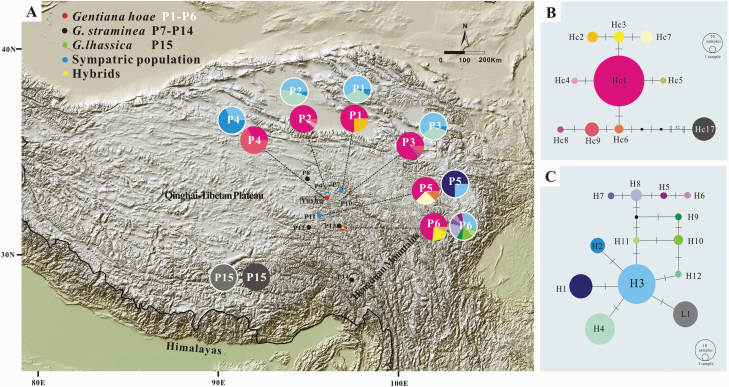
Geographical distribution and networks of plastid haplotypes (trnS-trnG and rpl32-trnL loci) and the internal transcribed spacer region in Gentiana hoae sp. nov. and closely related species. (A) Geographical distribution of the plastid haplotypes (inner pie charts) and ribotypes (outer pie charts, with white circles) across sampled populations. Pie charts display haplotype/ribotype frequencies in each locality. Map came from the Institute for Planets. (B) Network of the plastid haplotypes. (C) Network of the nrITS ribotypes. The relative sizes of the circles in the network are proportional to haplotype/ribotype frequencies. One short dash represents one nucleotide variation and black dots represent missing haplotypes.